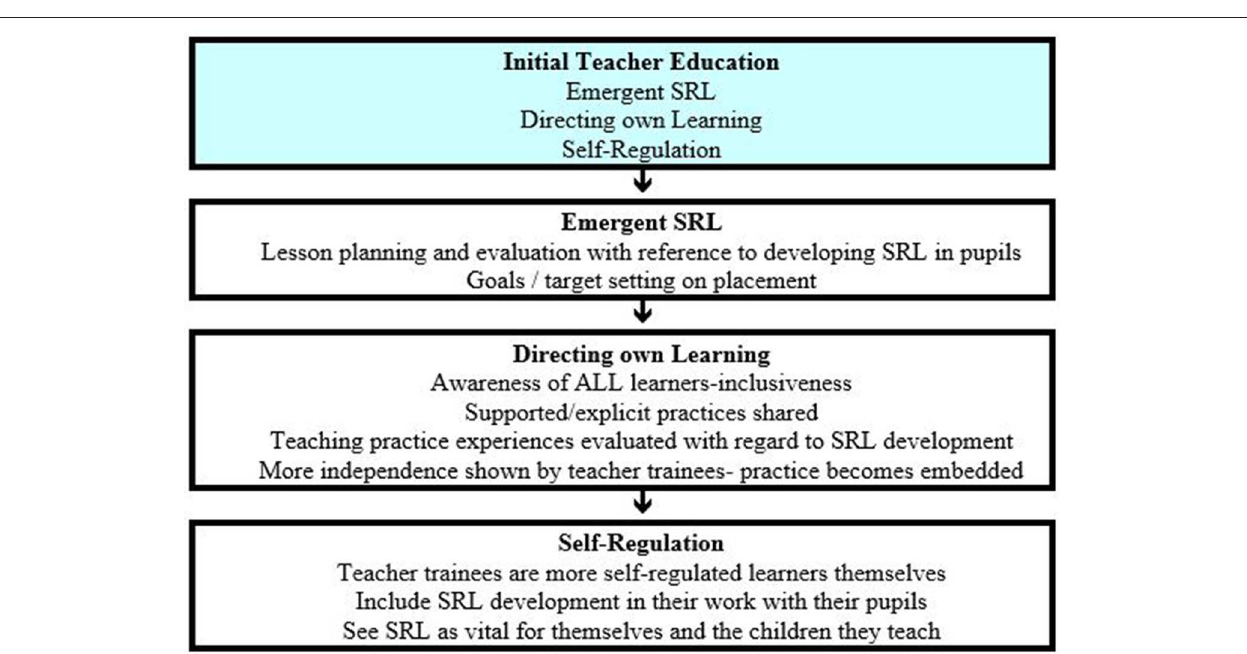
FIGURE 4 | Boekaerts’ adapted model framing teacher trainees SRL in